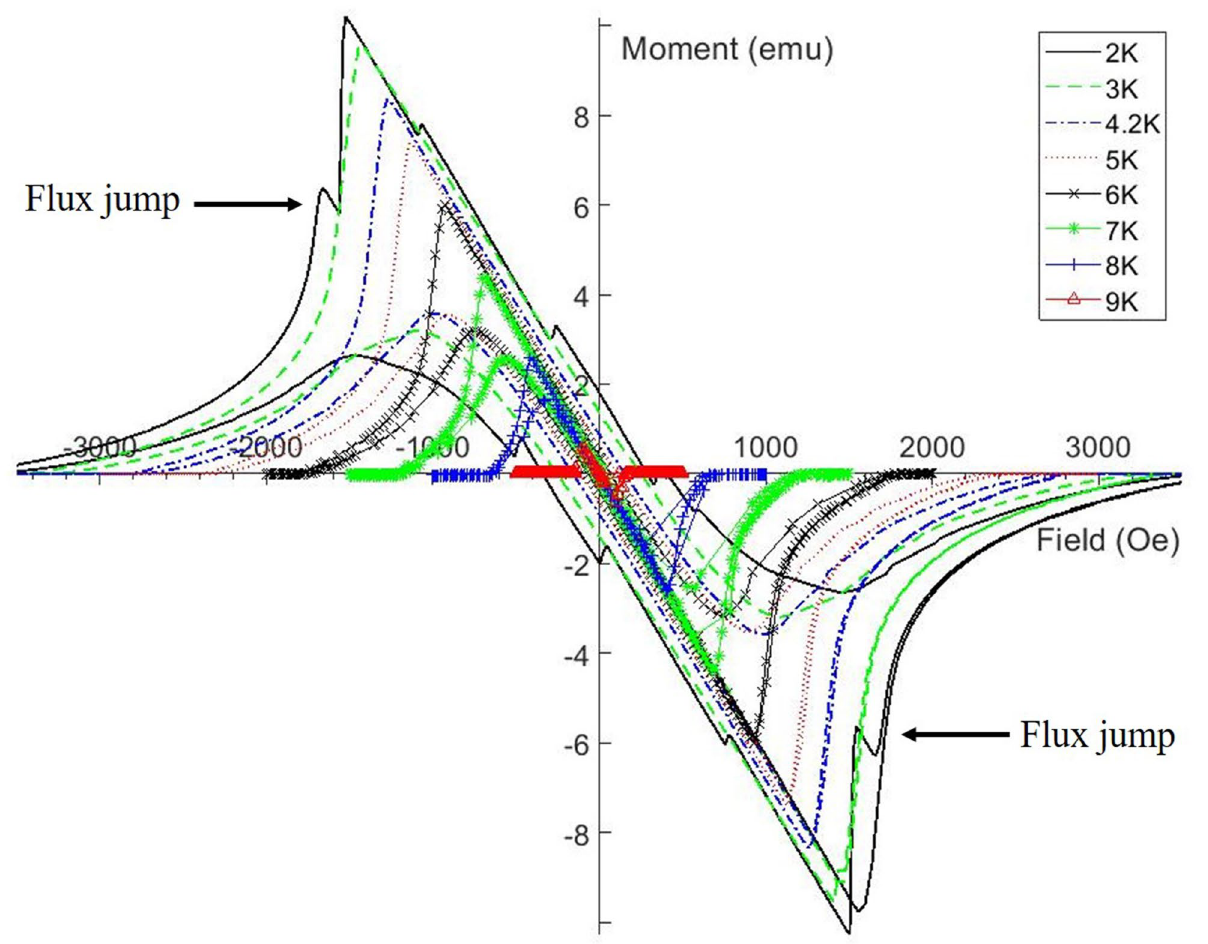
Figure 3. The hysteresis loops performed on the N infused sample at varying temperatures. Flux jumps can be seen once the sample had been taken above H c 2 for the 2 K data